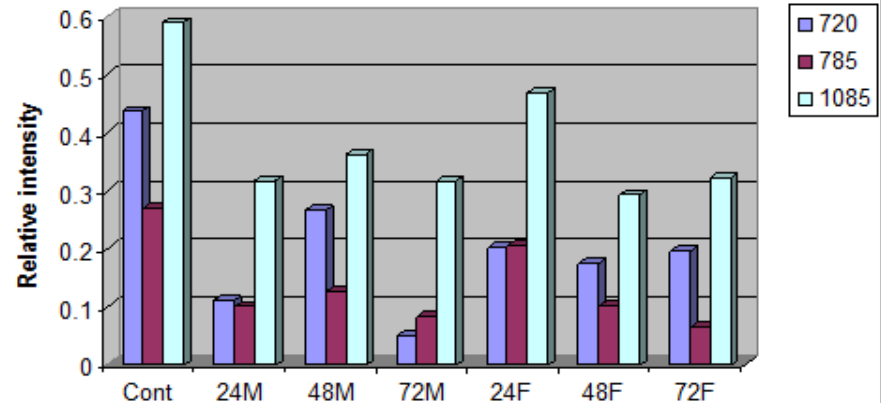
Figure 5. Spectral differences in Raman bands 720, 785 and 1085 cm −1 between freeze-dried treated and untreated cells. Caco-2 cells were incubated with 24 h ML or fish oil (F) radiated under UV light for 24, 48 and 72 h.